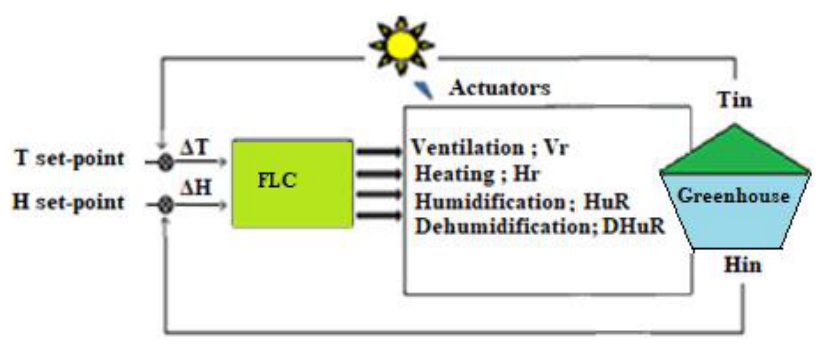
Figure 8. Schematic of the studied system.